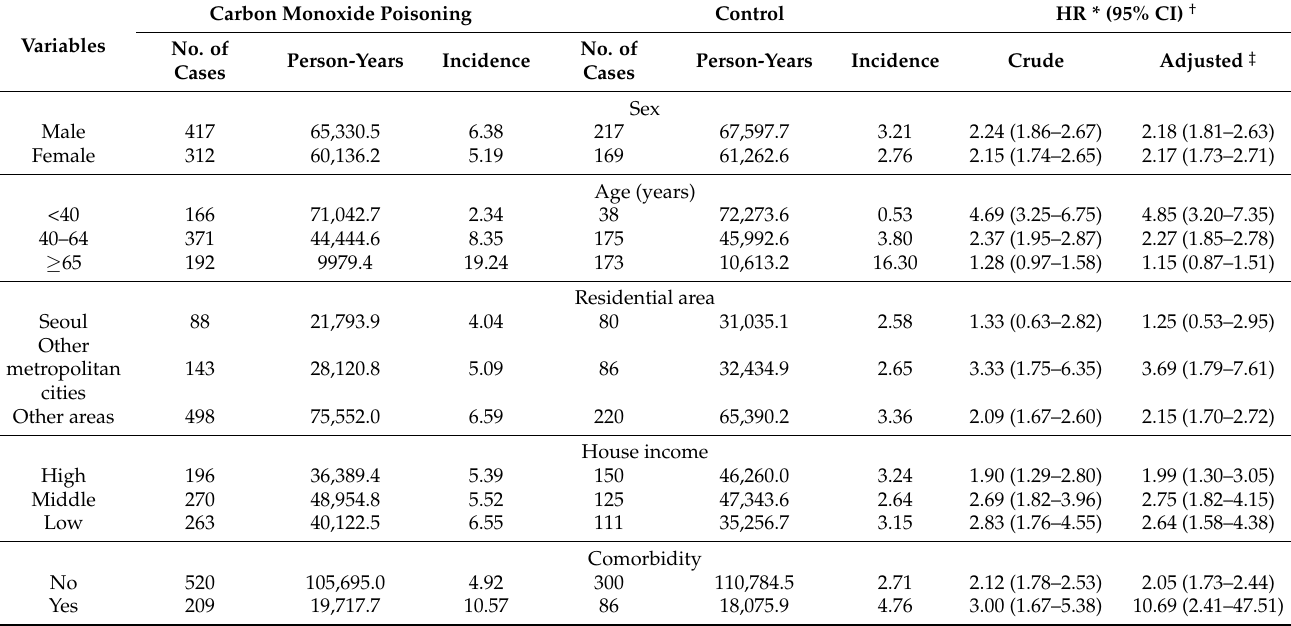
Table 3. Incidence rates and hazard ratios of ischemic heart disease as stratified by sex, age, residential area, household income, and comorbidities.